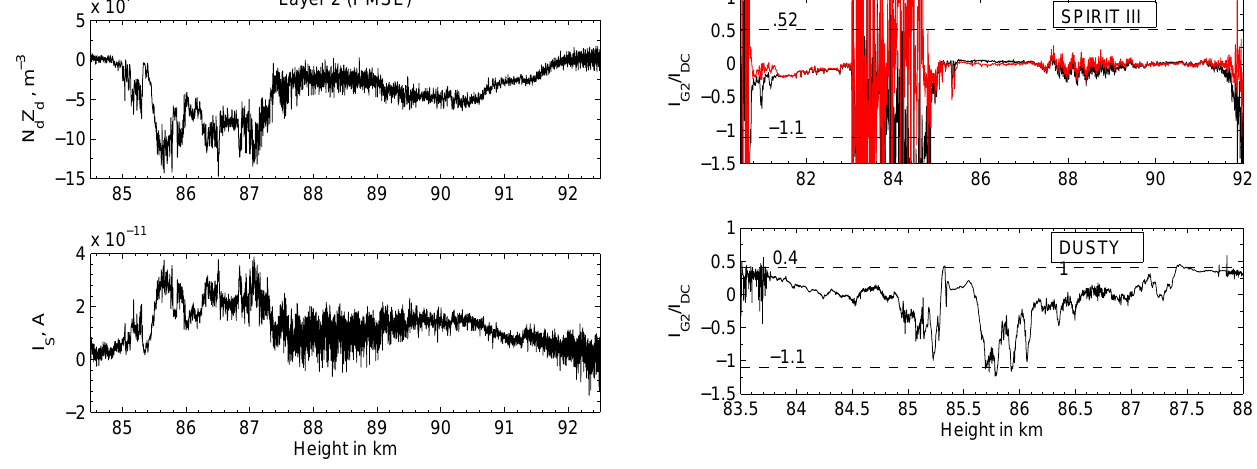
Fig. 8. As for Fig. 7 but for layer 2 (PMSE).